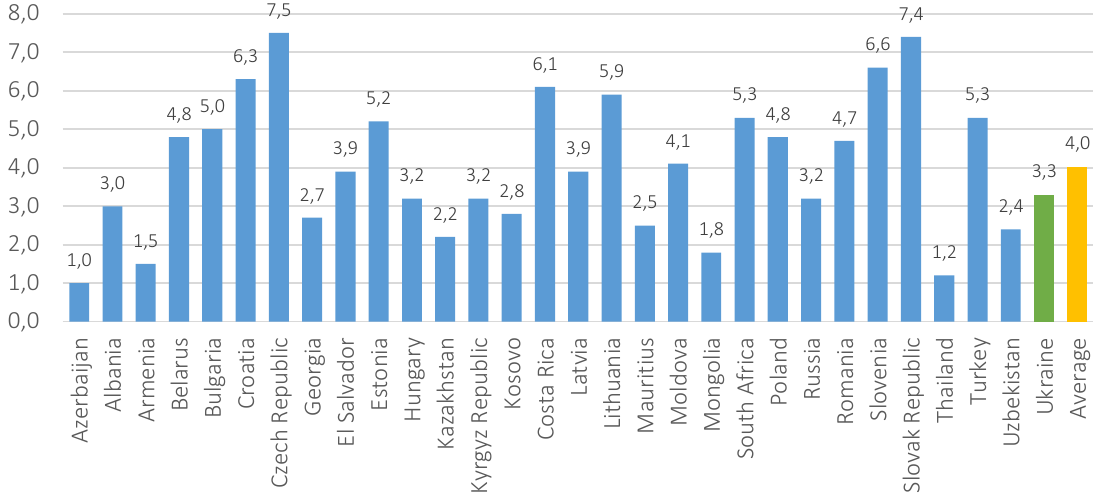
Figure 3. Public expenditure on health care in emerging market